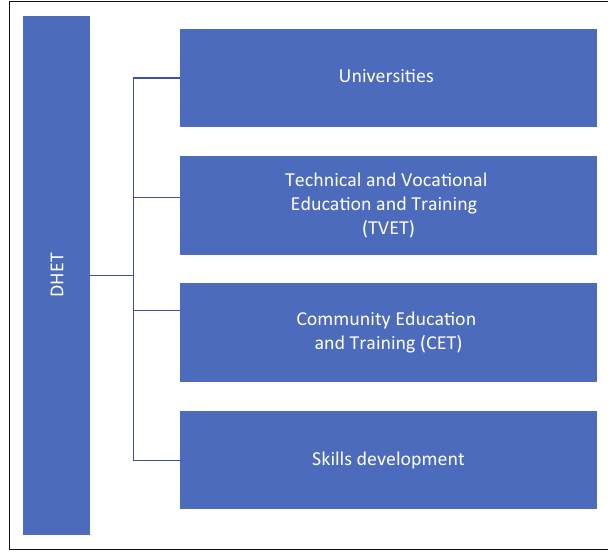
FIGURE 1: Higher education landscape in South Africa.